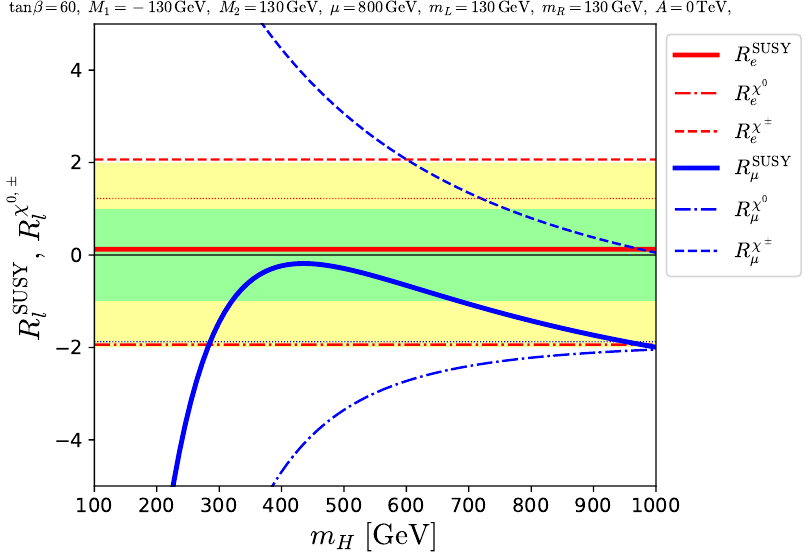
Figure 4 . The same as in (cid:12)gure 1 but as a function of m H in the scenario motivated by the Higgs mediation of SUSY breaking. Values of the relevant SUSY parameters are given above the plot.